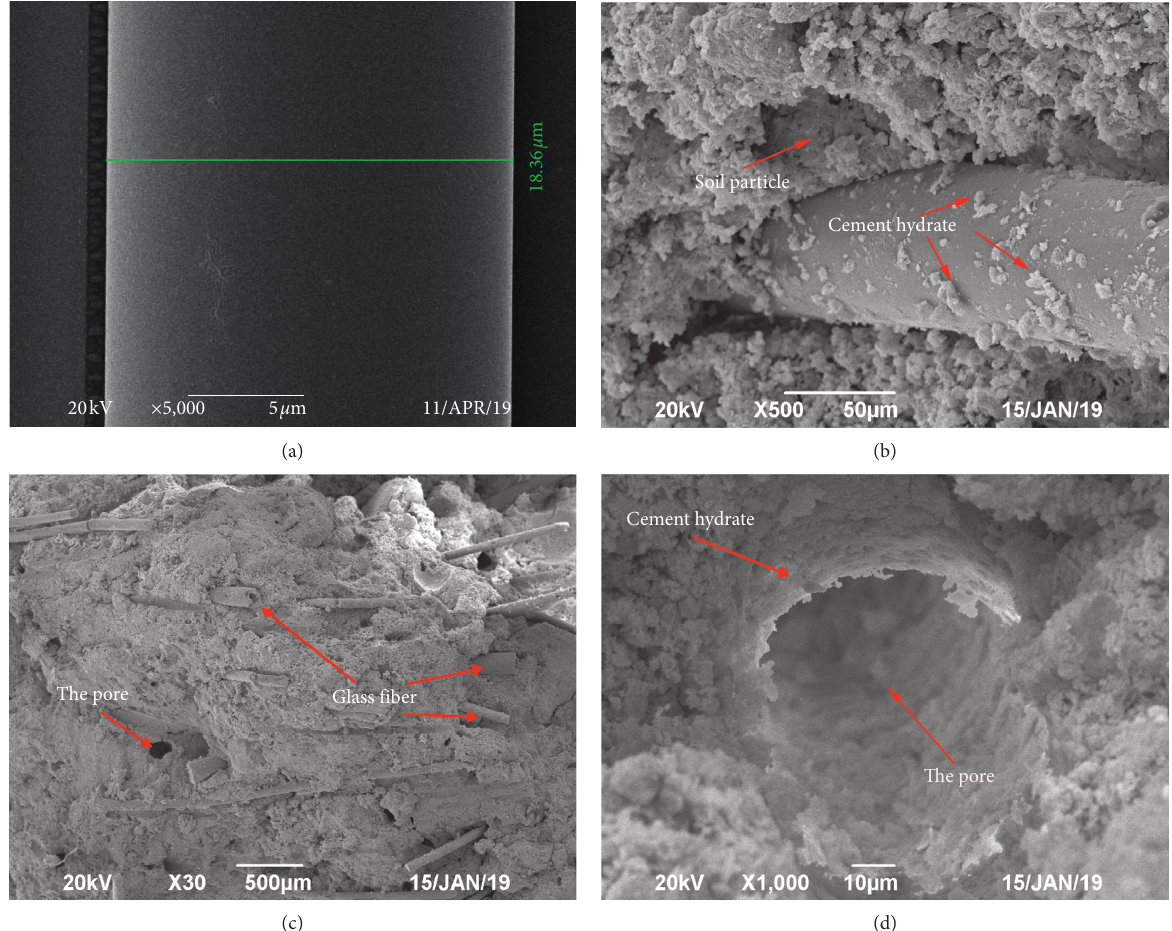
Figure 19: Cement-stabilized clay reinforced with glass fibers. (a) Glass fiber surface. (b) Cement hydrates and soil particles on the fiber surface. (c) Glass fibers embedded in soil. (d) The pore after the fiber was pulled out.